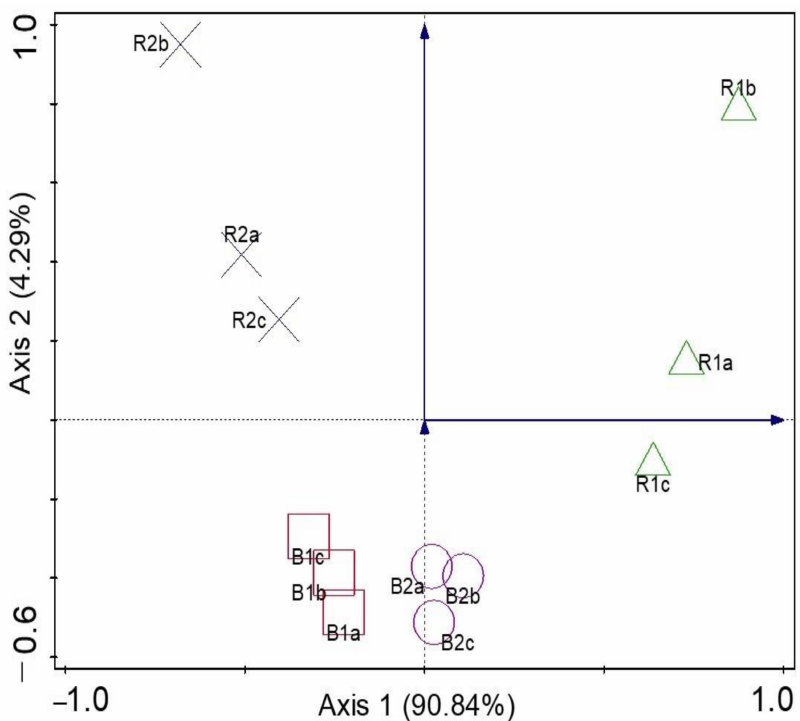
Figure 7. The gene diversity of the soil sample locations R1, R2, B1, B2 as displayed using principal coordinates analysis (PCoA).